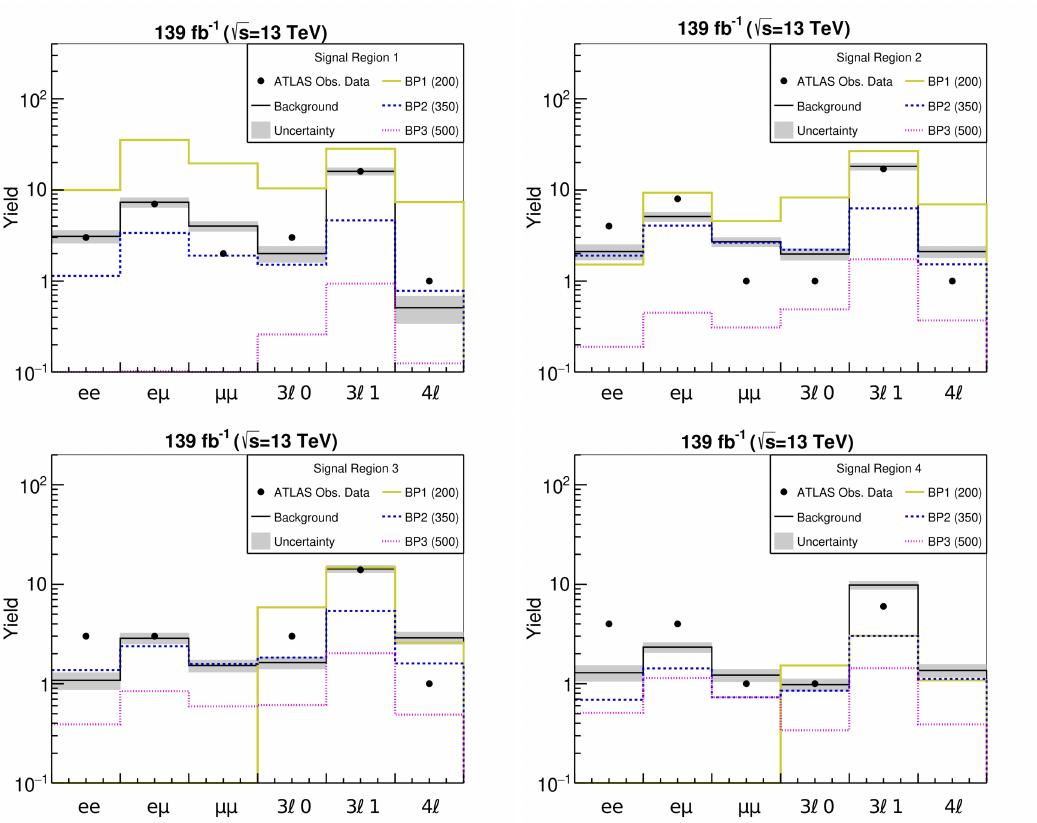
Figure 3 . The the expected background, signal and observed events for four different SRs. For each SR, the yields are shown for all the channels. The signal predictions are shown for three benchmark masses. See text for